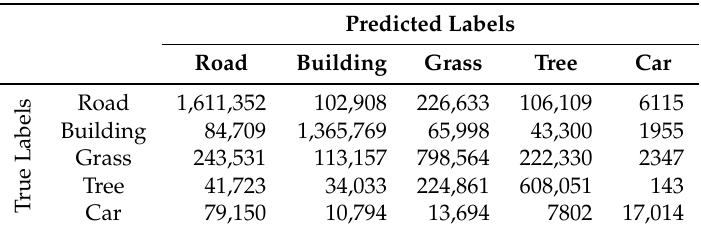
Table 6. Confusion matrix obtained for classified Felzenszwalb segmentation based on a before- segmentation fusion (Figure